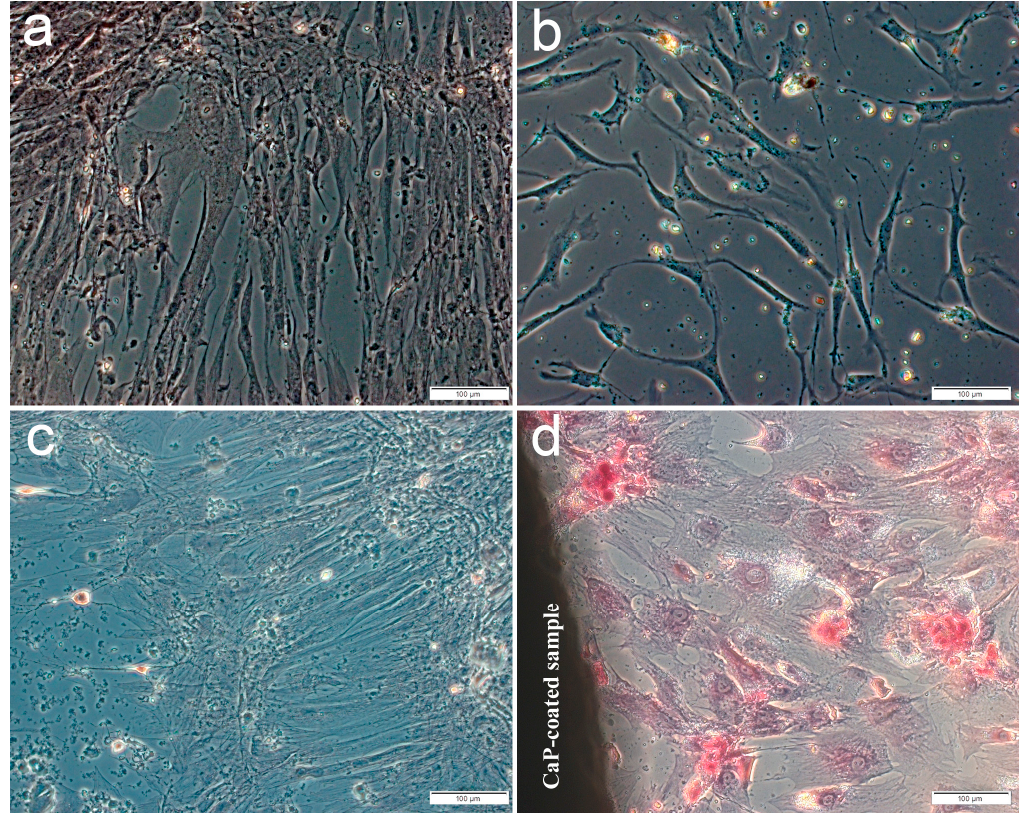
Figure 1. Culture of human adipose-derived mesenchymal stem cells on plastic after 14 ( a,b ) or 21 days ( c,d ) in a standard nutrient medium: a , c —control; b , d —around the microarc CaP-coated titanium sample. Staining with alizarin red S. Scale 100 μ m Table 2. Osteogenic differentiation of hAMSCs on plastic after 21 days of in vitro coculture with the microarc CaP ‐ coated titanium substrates, Me (Q1–Q3).